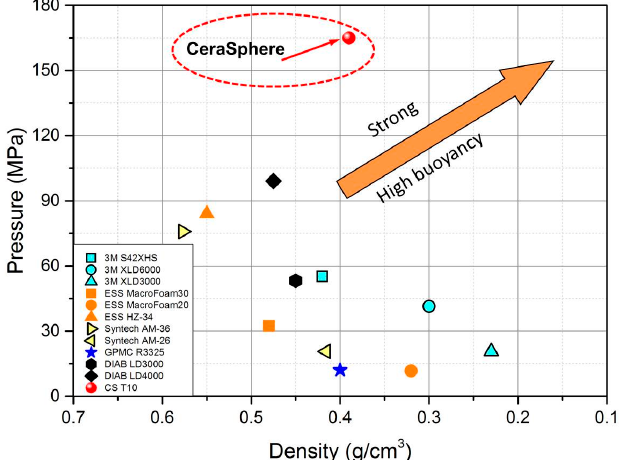
Figure 8. A benchmark comparison of the ceramic sphere and other commercial buoyancy products in terms of hydrostatic compressive burst strength and density [24–29].